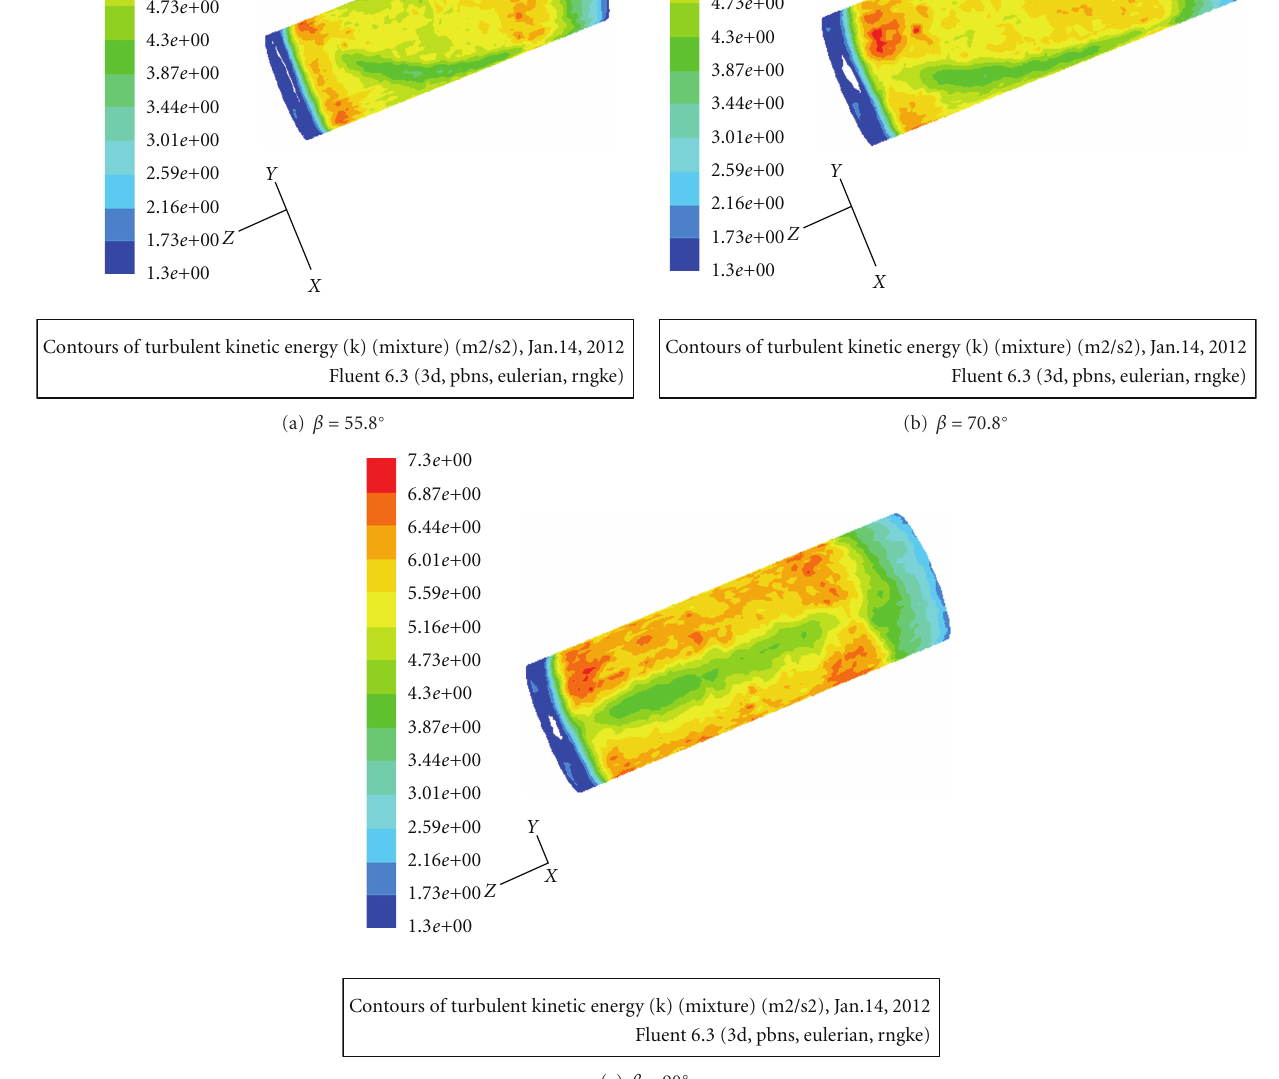
Figure 8: Turbulent kinetic energy distribution in shearing chamber with di ff erent blade laying angles.